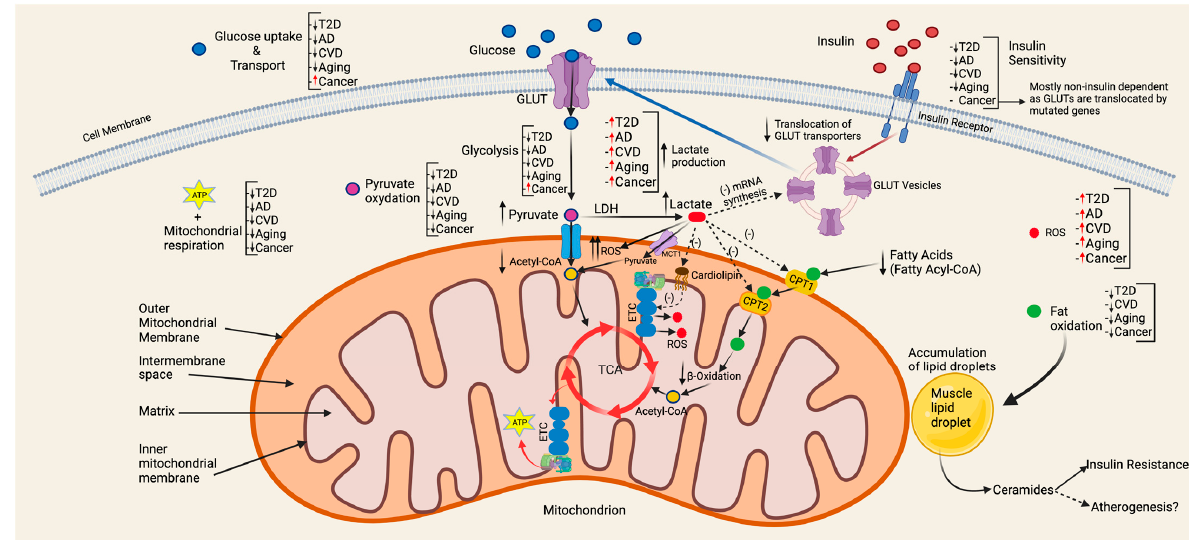
Figure 2. Representation of the role of mitochondrial dysfunction and disrupted bioenergetics in some of the most prevalent diseases in our society. (Red arrows indicate increased production or production in multiple diseases and black arrows indicate decreased production or function).